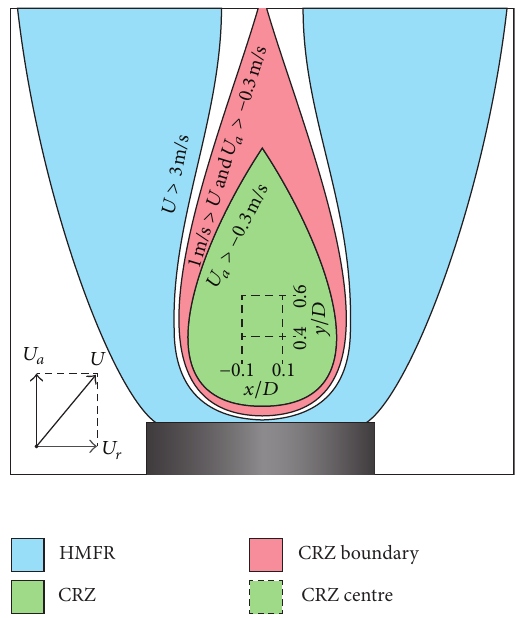
Figure 2: Designation of areas within the